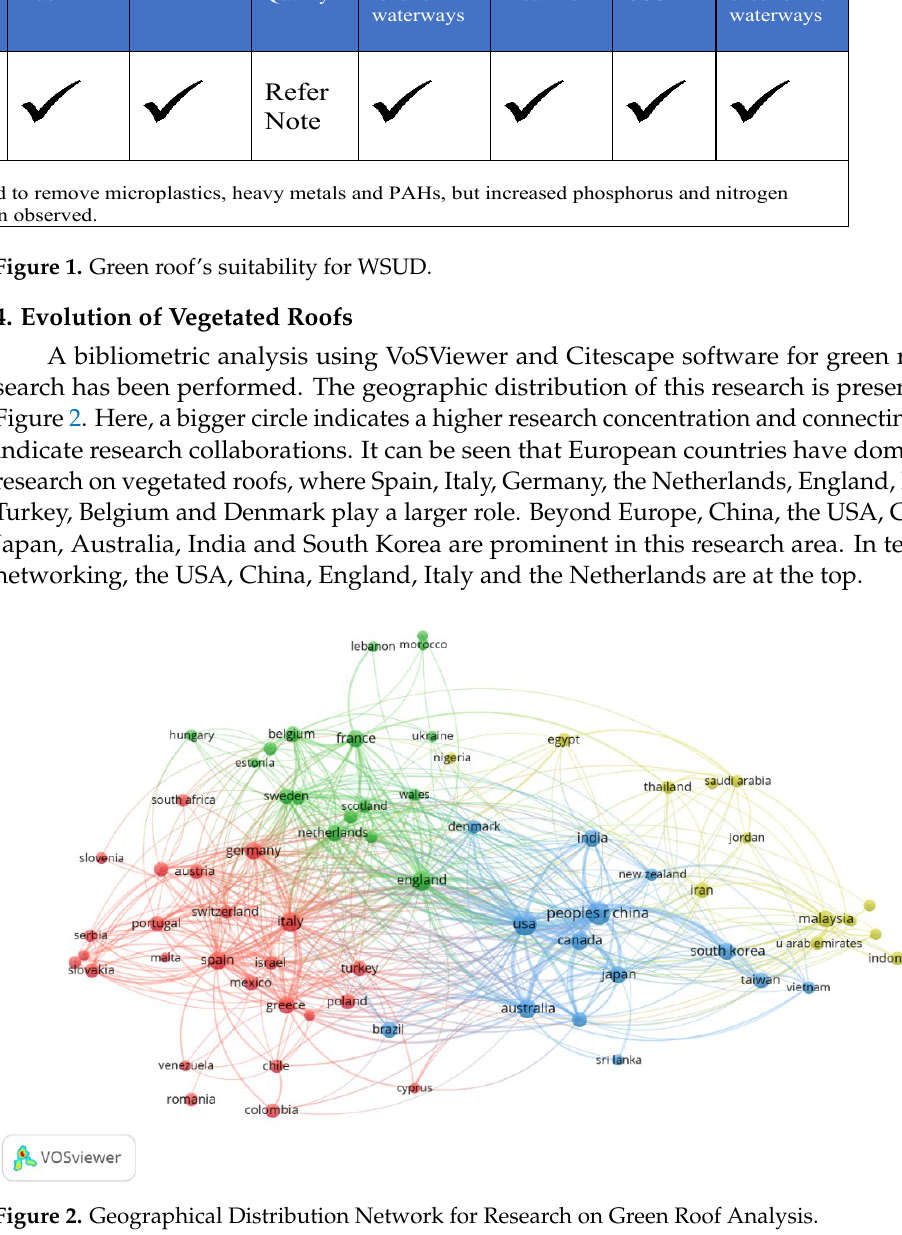
Figure 2. Geographical Distribution Network for Research on Green Roof Analysis .